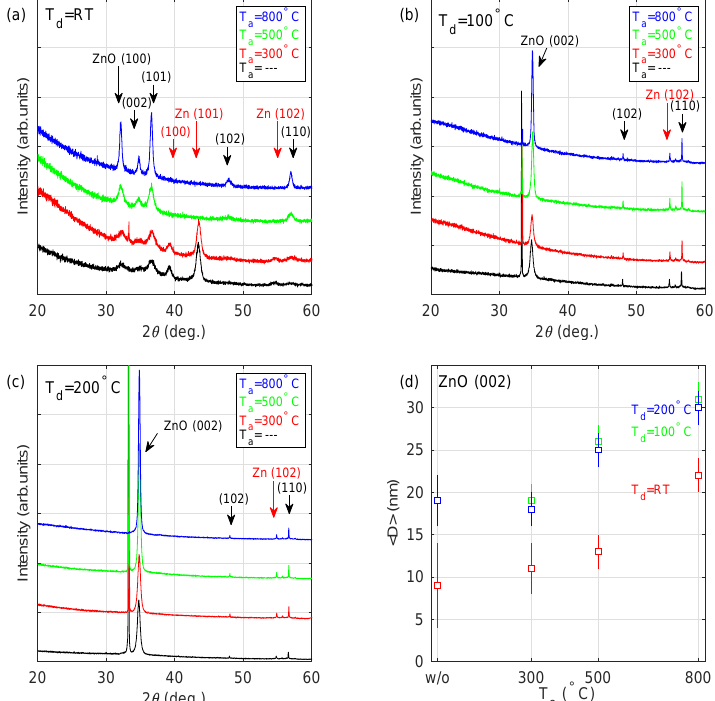
Figure 4. XRD patterns for the samples deposited at ( a ) room temperature, ( b ) 100 ◦ C and ( c ) 200 ◦ C and annealed at 300, 500 and 800 ◦ C. ( d ) The average size ( < D > ) of the ZnO(002) crystallite.